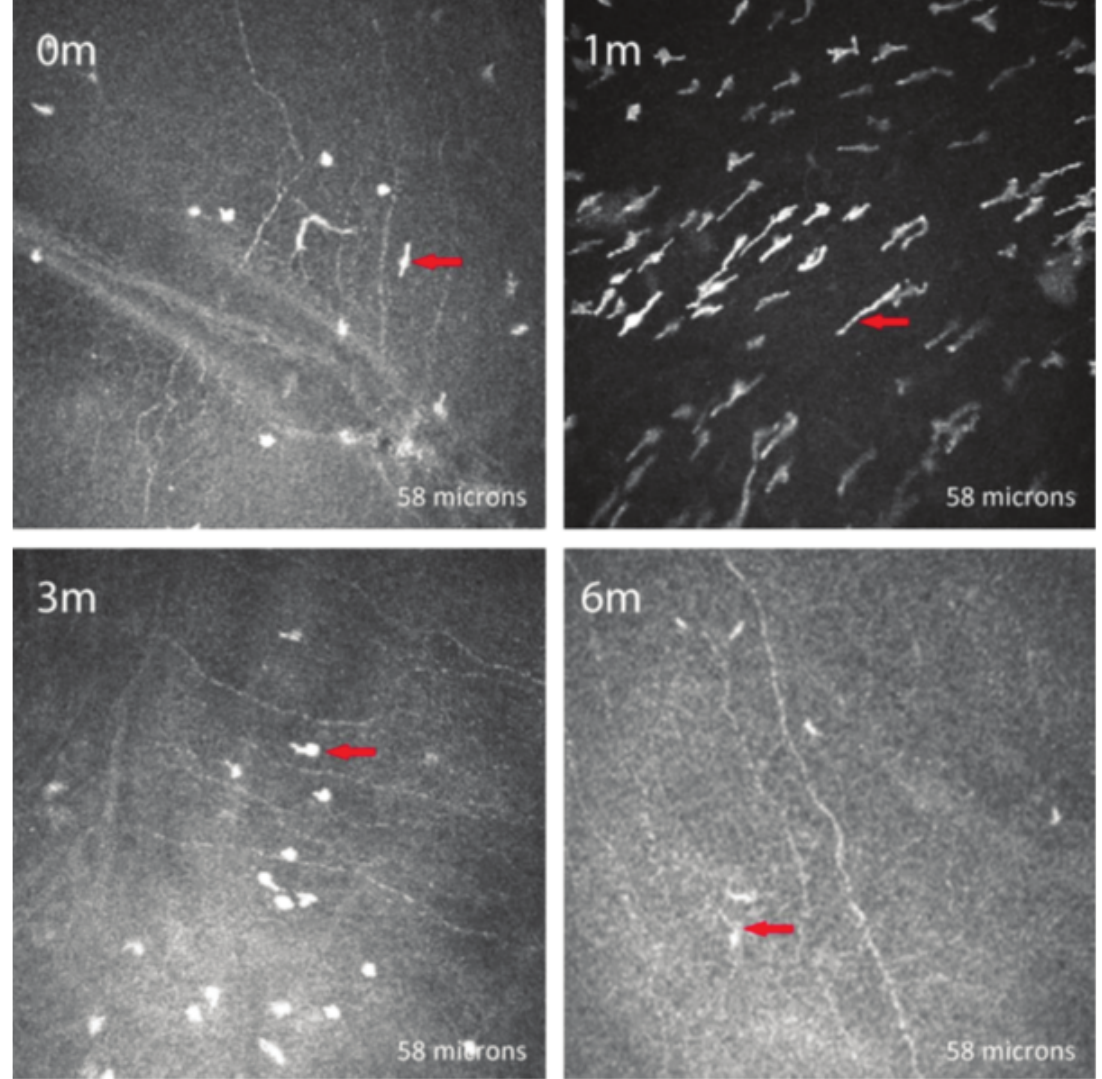
Figure 2. In vivo confocal microscopic images of Bowmans membrane in a representative patient, taken at the same level at each visit. The preoperative scan shows tortuous nerve fibers (0 m). Nerves appear fragmented at one month (1 m) and three months (3 m); nerve regeneration is seen at six months (6 m). dendritic cells (arrows) are also seen, which appear hyper-reflective and elongated after crosslinking and revert to the original morphology by six